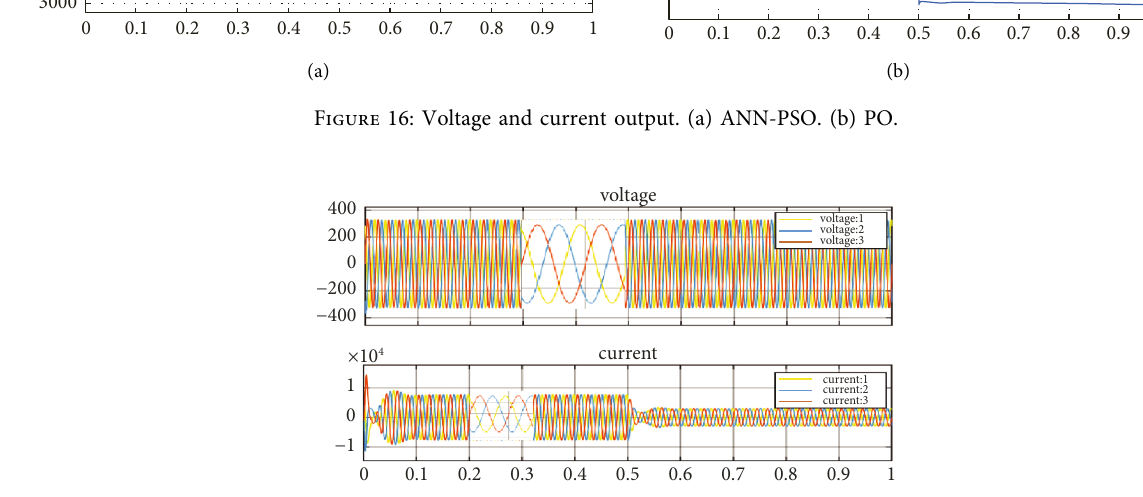
Figure 17: The phase voltages and currents at the inverter.